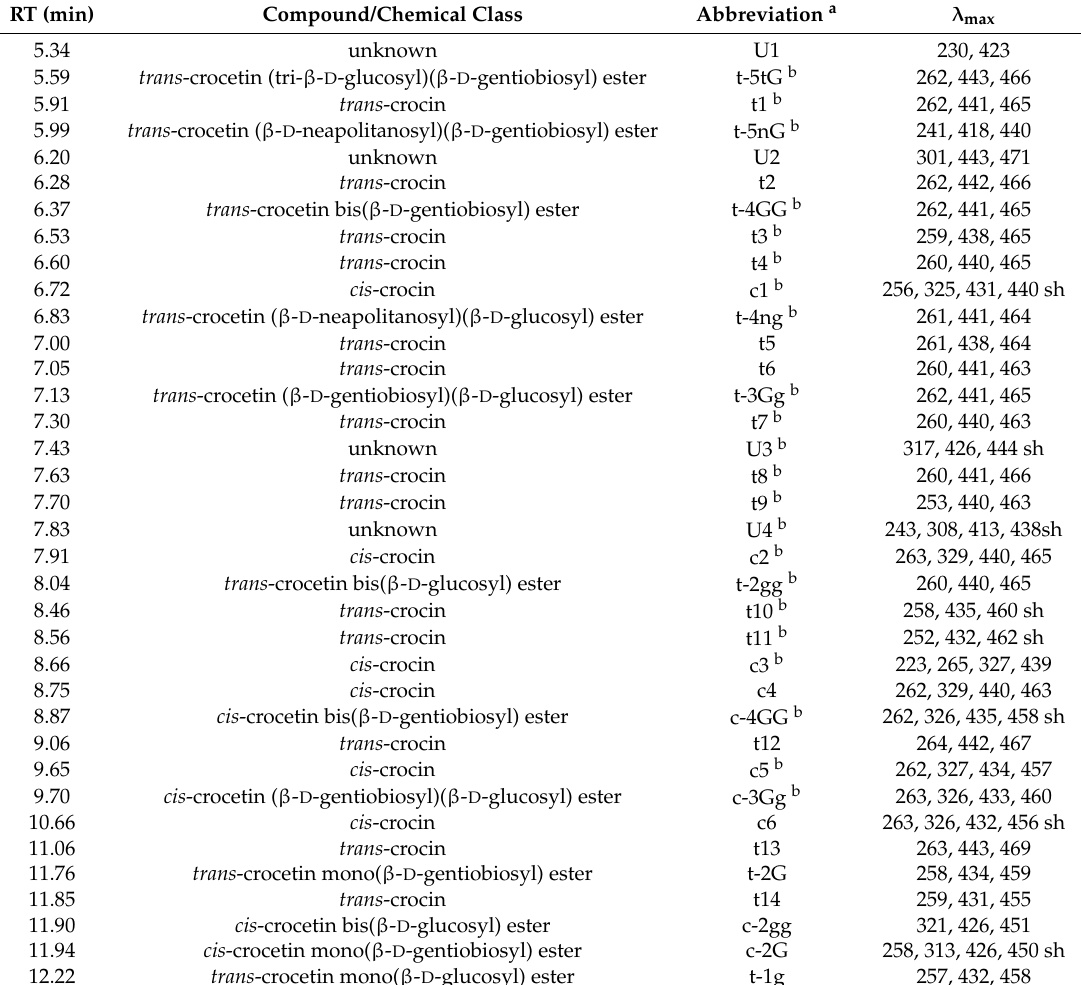
Table 1. List of the saffron metabolites found in the UHPLC-DAD chromatograms detected at 440 nm collected with the column Kinetex C18: retention time (RT) observed under application of the optimal separation conditions, assigned structure or chemical class, absolute and relative maxima of the absorption